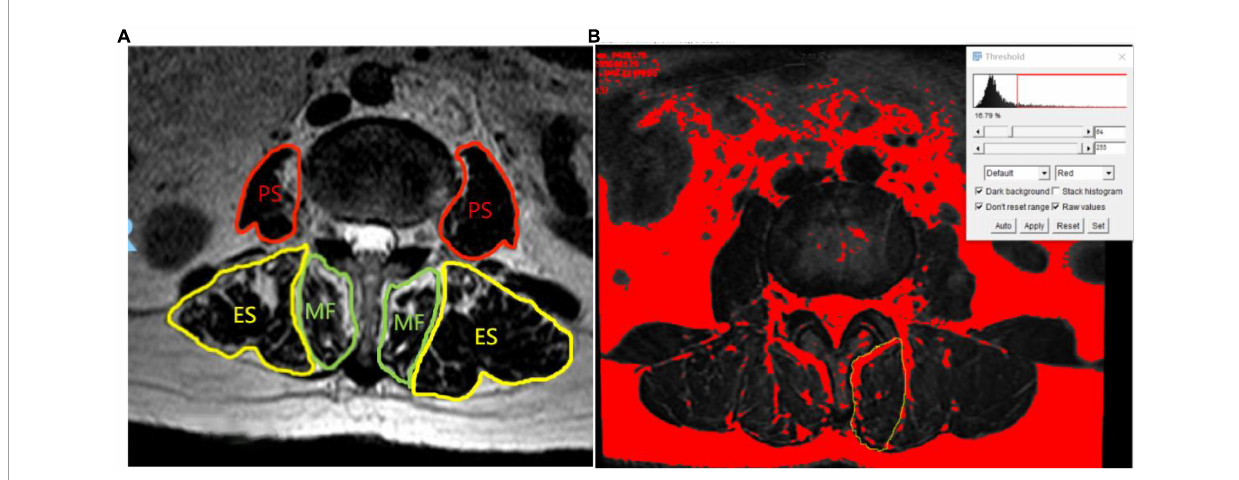
FIGURE1 Measurement of cross-sectional area and intermuscular fat area of paraspinal muscle (A) (MF, multifidus; ES, erector spinae; PS, psoas major). (B) The automatic threshold setting of ImageJ distinguish fat from muscle. The range of the yellow curve is the left MF, and the red part is the fat area of MF.